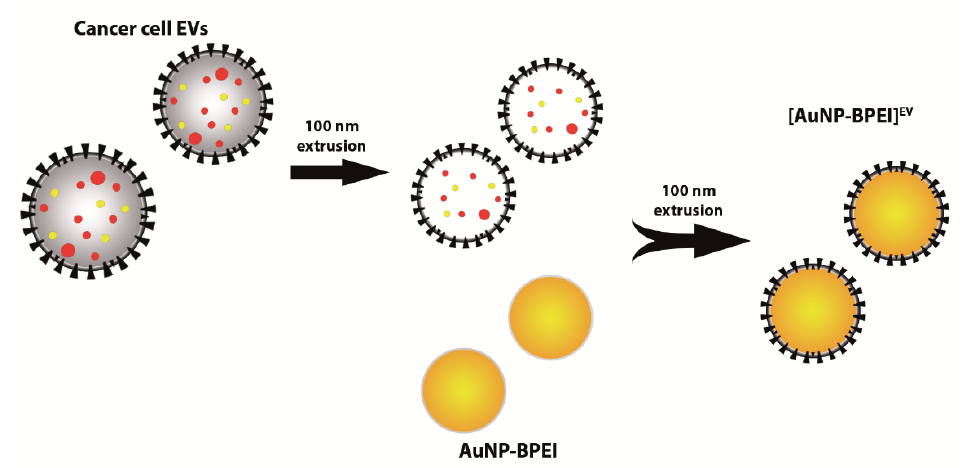
Figure 1. Functionalization of AuNP with cancer EV membranes. Density gradient-purified cancer cell EV are first extruded through a 100 nm membrane, resulting in size homogenization and alteration